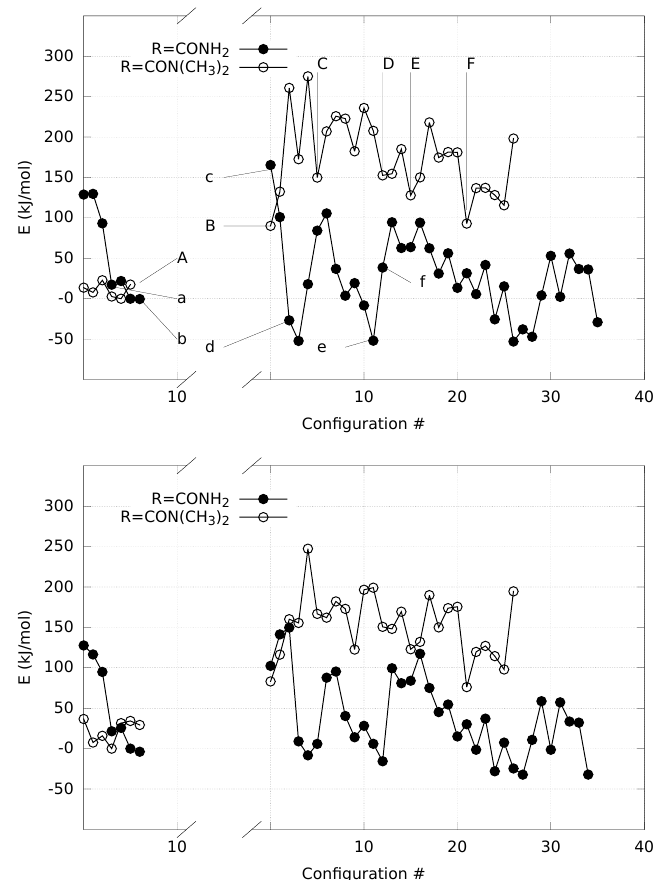
Figure 5. Potential energy with R= H NCO (filled circles) and (CH ) NCO (circles) along with the 2 3 2 extraction of α H from the bond with C α atom. Energy is computed for solute within a distance O(water)-solute atoms of 4 Å (see Methods). Energy reference is the lowest energy obtained in the initial nitro form for each compound. The gap in the x -axis separates nitro (left) from nitronate and aci (right) species. Arrows in the left panel indicate the configurations displayed in Figures 6 and 7. The calculation is performed with plane-wave basis-set and PBE exchange functional (left) and localized Gaussian basis-set with hybrid B3LYP exchange functional (right panel). Points indicated with a–f and A–F are are displayed in Figures 6 and 7, respectively. See text for